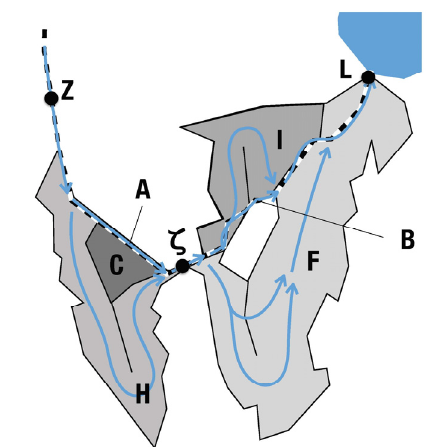
Figure 2. The present Kis-Balaton Water Protection System. Z: Zala River; H: Lake Hídvégi inundated in phase 1; C: emergency reservoir to enclose and treat pollution (e.g., oil spill) from Z; A: bypass of H; ζ : connector between phases 1 and 2 (a section of the Zala River); I: Ingói Reeds; F: Lake Fenéki inundated in phase 2, B: bypass of F; L: inflow into Lake Balaton. Black dots indicate major monitoring sites of inputs and outputs, blue arrows indicate alternative, adjustable pathways of flow.